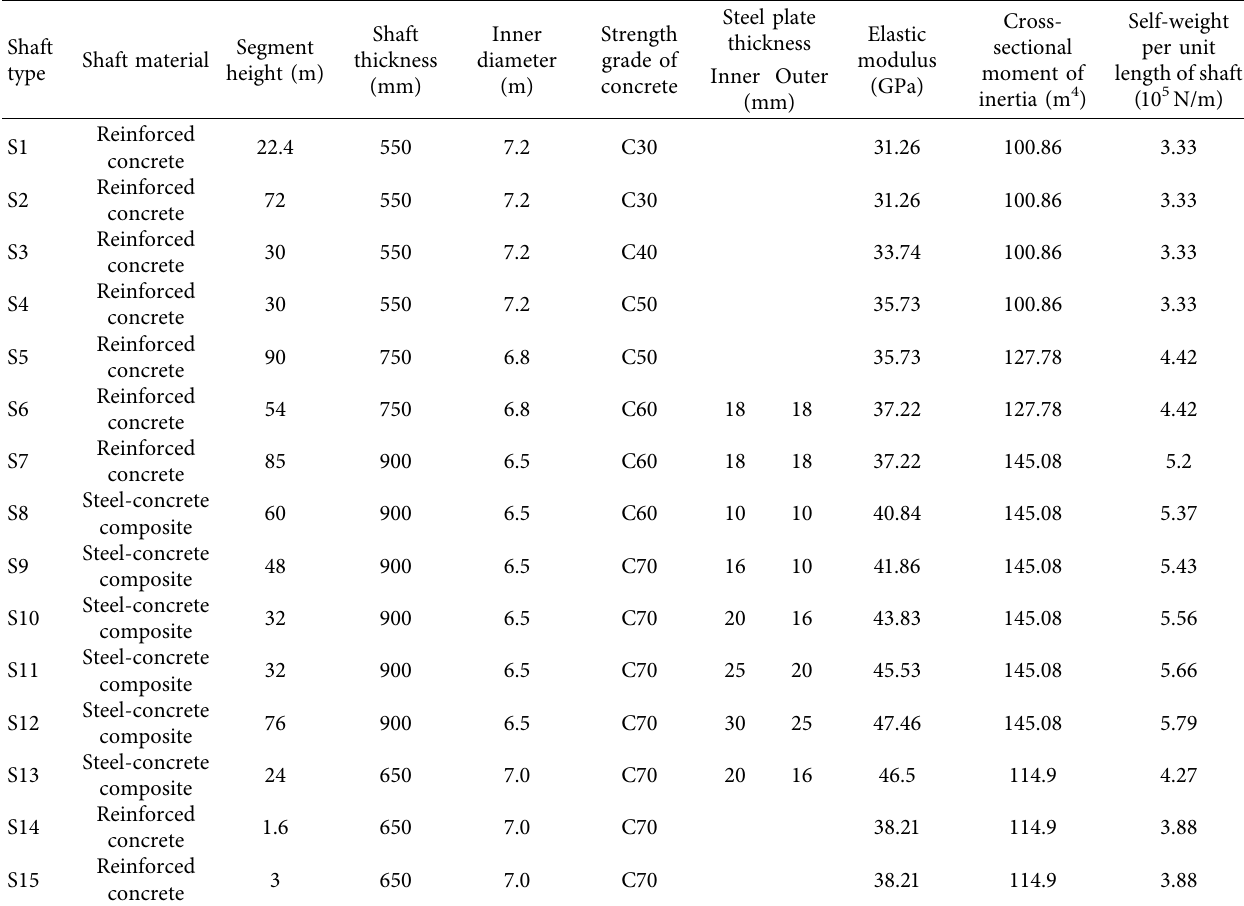
Table 1: Calculating parameter table of the drilling shaft lining.